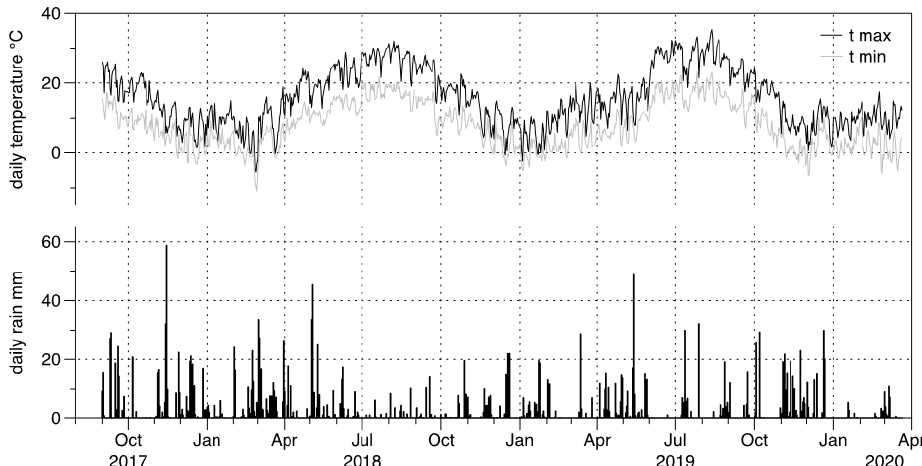
Figure 1. Daily rain and maximum and minimum daily temperatures were measured during the experiment by a meteorological station 10 km from the experimental field (Sistema Informativo Regionale Meteo-Idro-Pluviometrico).